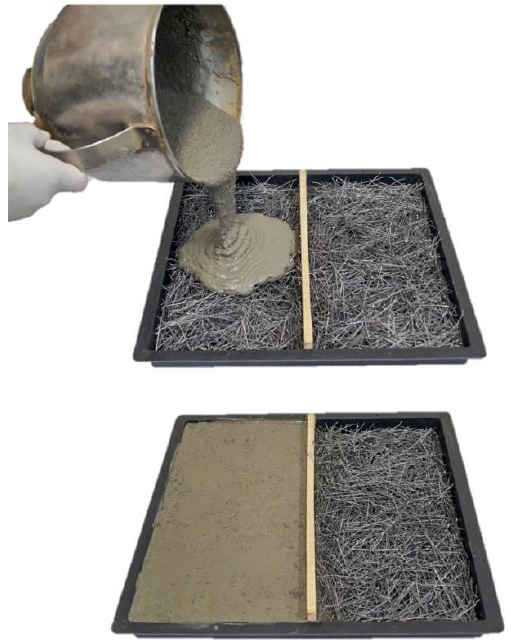
Figure 1. Slurry infiltration method.